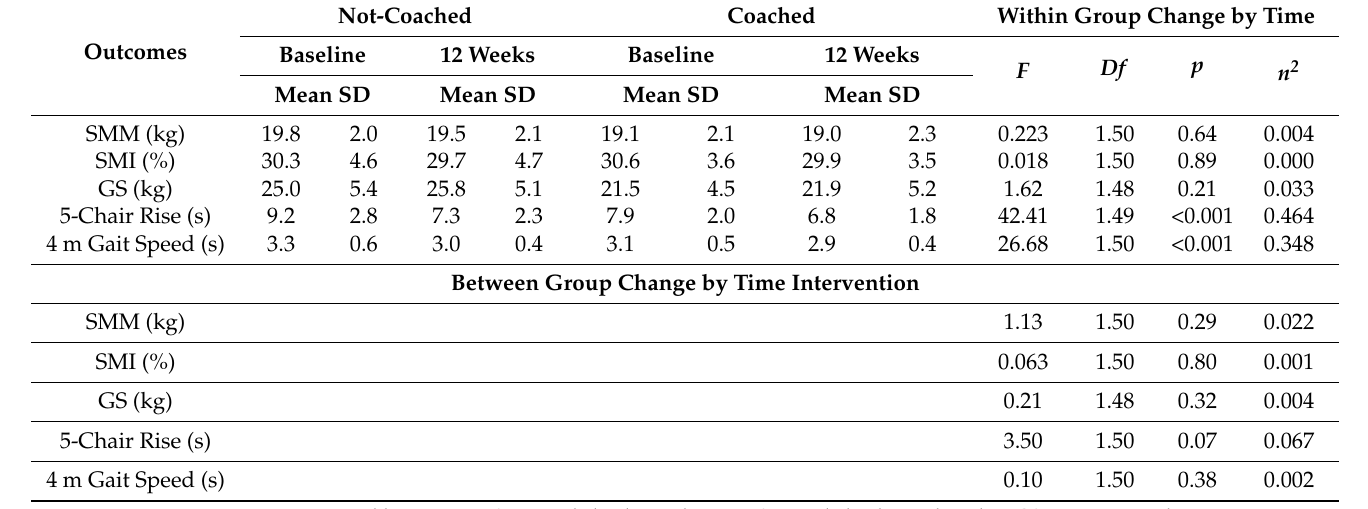
Table 3. Skeletal Muscle Mass (SMM), Skeletal Muscle Index (SMI), Grip Strength (GS), Five-Chair Rise, and 4-m (4 m) Gait Speed Measures of Participants at Baseline and 12